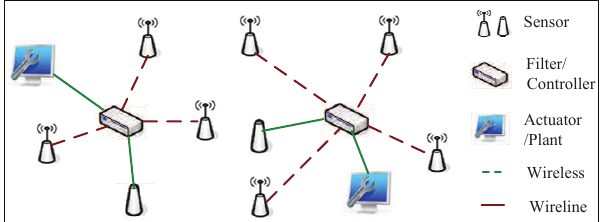
Figure 1. Distributed